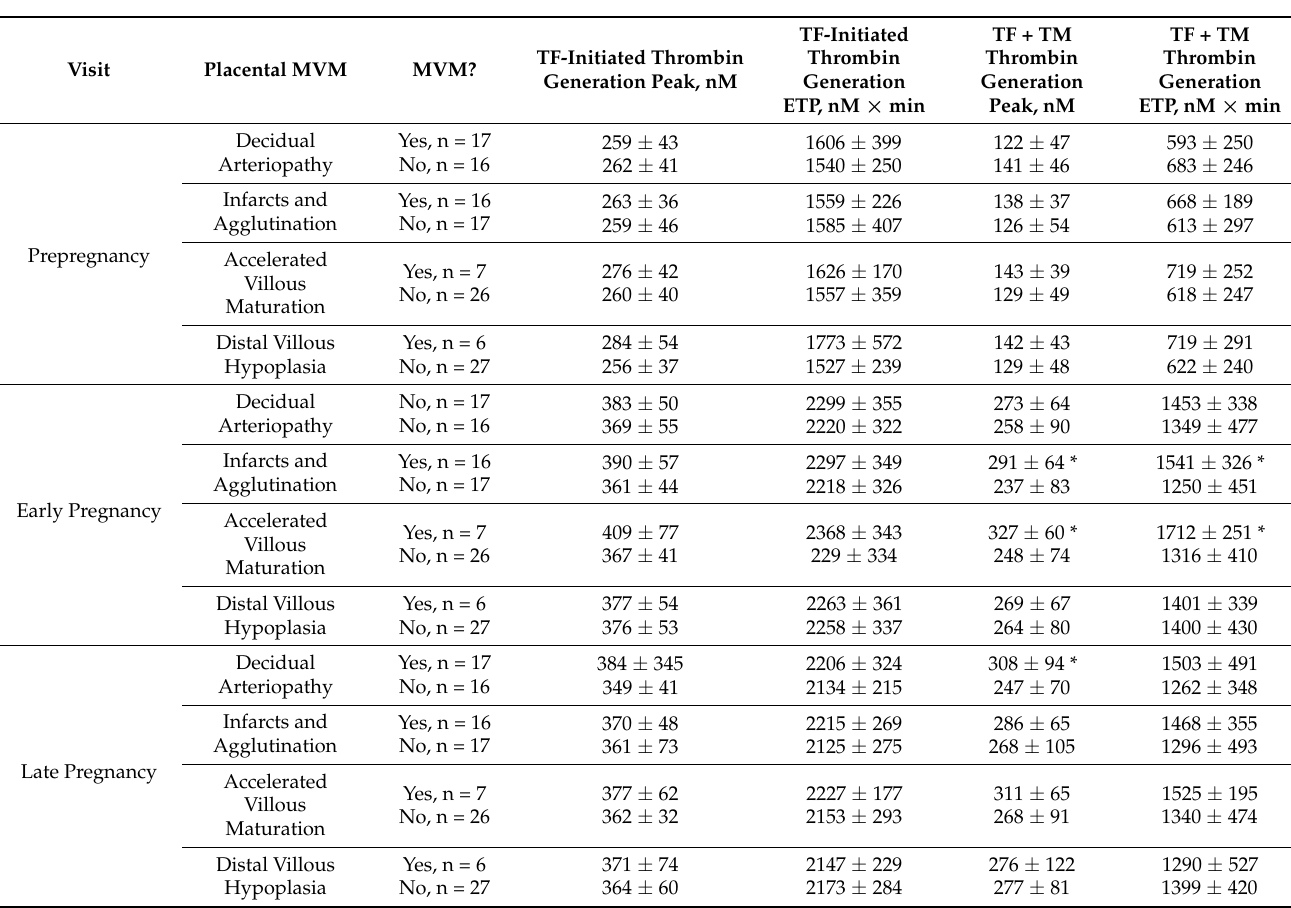
Table 3. Results of the 33 placentas with thrombin generation assay results in the presence of tissue-factor initiation with and without the presence of thrombomodulin. Data presented as mean ± standard deviation with * representing statistical significance between the presence/absence of individual placental characteristics of